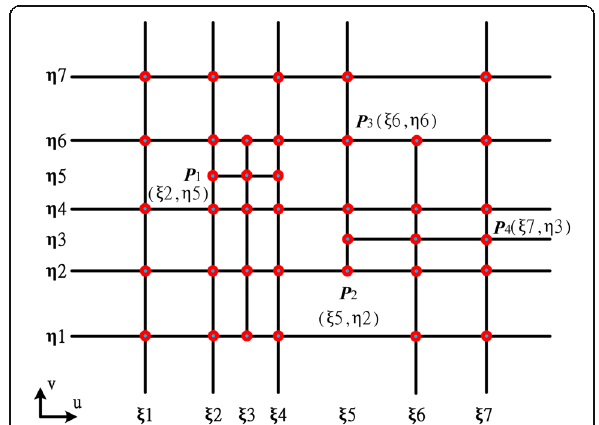
Fig. 3 A global parametric coordinate system